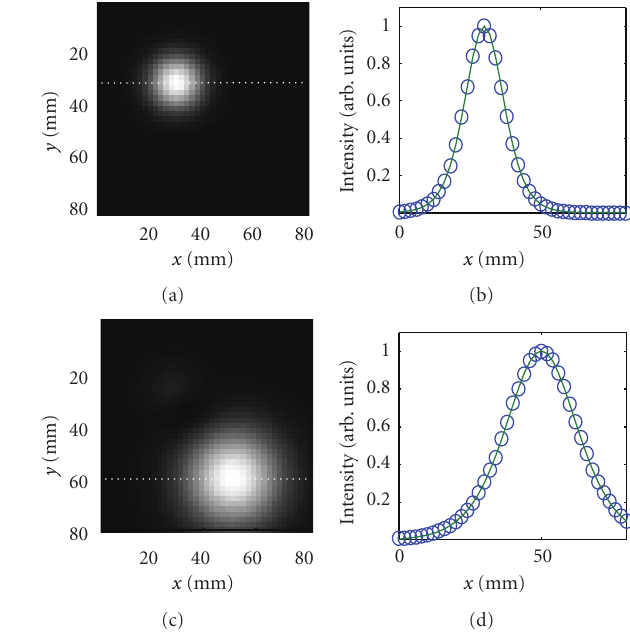
Figure 5: NMF-extracted two-dimensional intensity distribution on the detector plane of: (a) the centrosymmetric component of the scattering target; (c) the absorptive target. Fits to the corresponding spatial intensity profiles along the dashed line (shown in figures) are shown in (b) and (d), respectively.